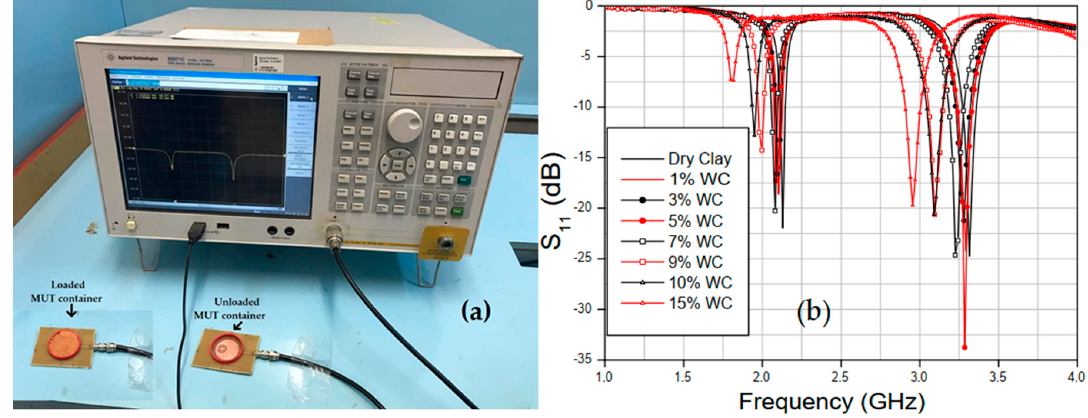
Figure 8. Red clay sample experimental procedure: ( a ) Measurement setup; ( b ) S 11 variation for different SWC.